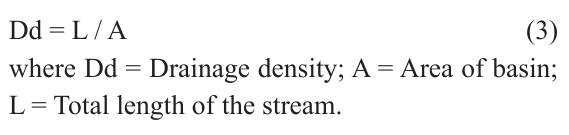
Table 2 . Five classes of drainage